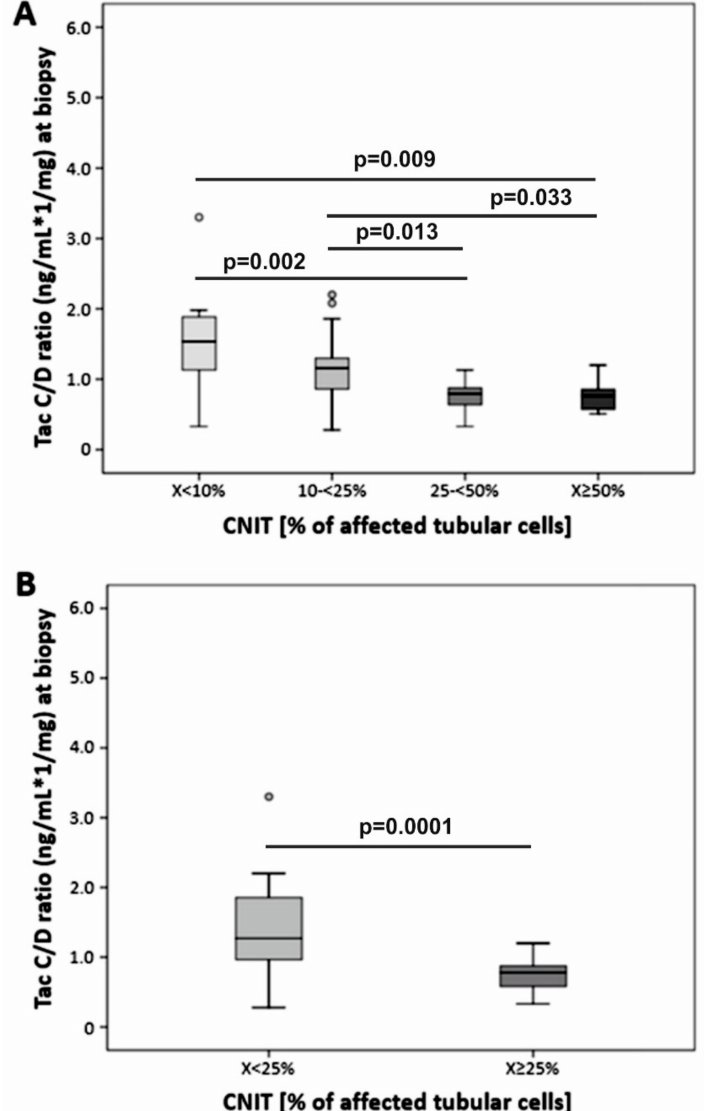
Figure 3. Histological analysis of calcineurin inhibitor-induced nephrotoxicity (CNIT) in kidney transplant biopsies, assessing the degree percentage of tubular cells with isometric vacuolization of the cytoplasm. The C / D ratio indicated a strong negative association with the severity of